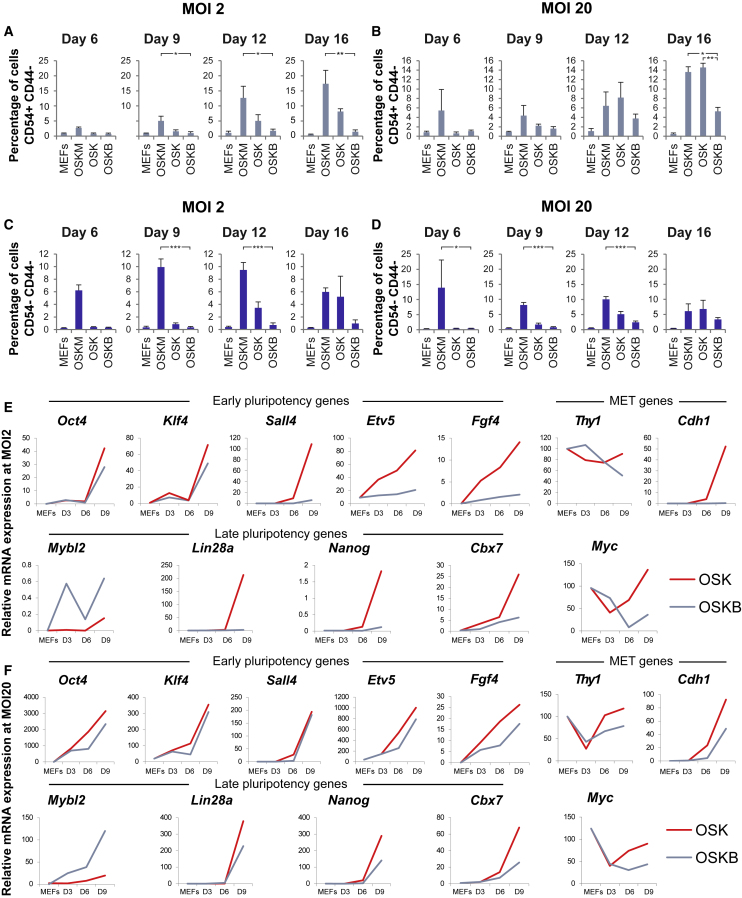
Reprogramming Kinetics in MEFs with Mybl2 Overexpression(A–D) MEFs were transduced with OSK, OSKM, or OSKB lentiviral particles at MOI 2 (A and C) or MOI 20 (B and D) and then cultured up to 16 days. At days 6, 9, 12, and 16, MEFs were stained with CD44-APC and CD54-PE-Cy7 antibodies, and reprogramming kinetics were analyzed by flow cytometry. Graphs represent the percentage of CD44−/CD54+ or of CD44−/CD54− cells. Error bars represent SEMs. n = 3 biological replicates. ∗p < 0.05, ∗∗p < 0.01, ∗∗∗p < 0.001.(E and F) Wild-type MEFs were reprogrammed with OSKB or OSK lentiviral particles at MOI 2 (E) or MOI 20 (F). At days 3, 6, or 9, expression of the indicated gene was measured using qRT-PCR normalized against the β2-microglobulin gene and then expressed relatively to WT ESCs expression or MEFs (Thy1 only).One representative graph is shown; n = 3 biological replicates, each with 3 technical replicates.See also Figures S3 and S4.